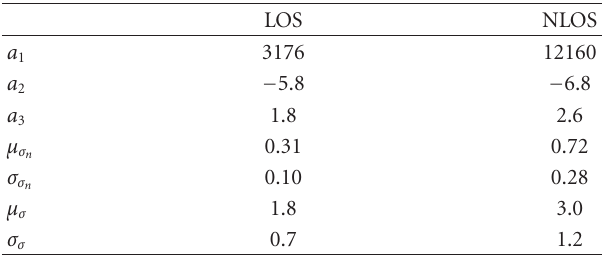
Table 1: Values of model parameters.